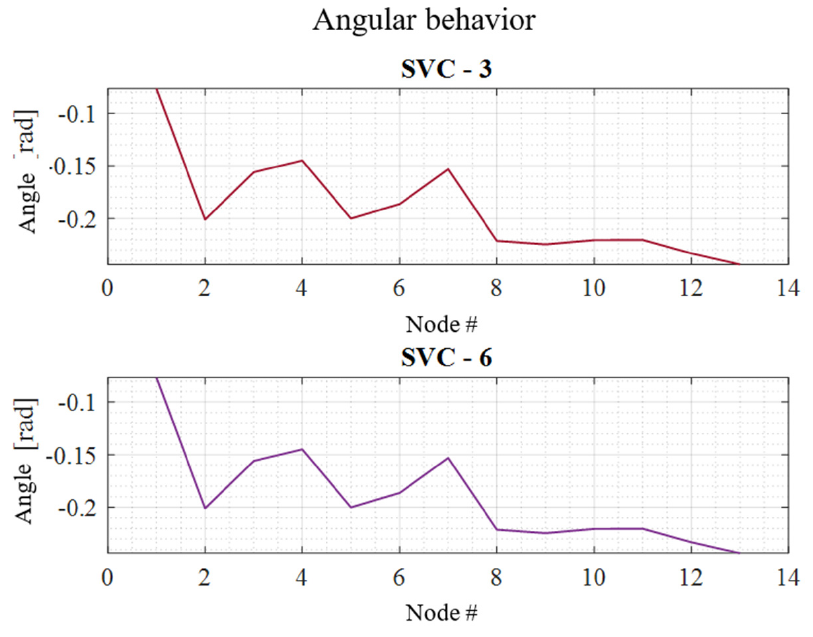
Figure 8. Angle profile in the IEEE 14-bus test system: SVC 3 and 6.